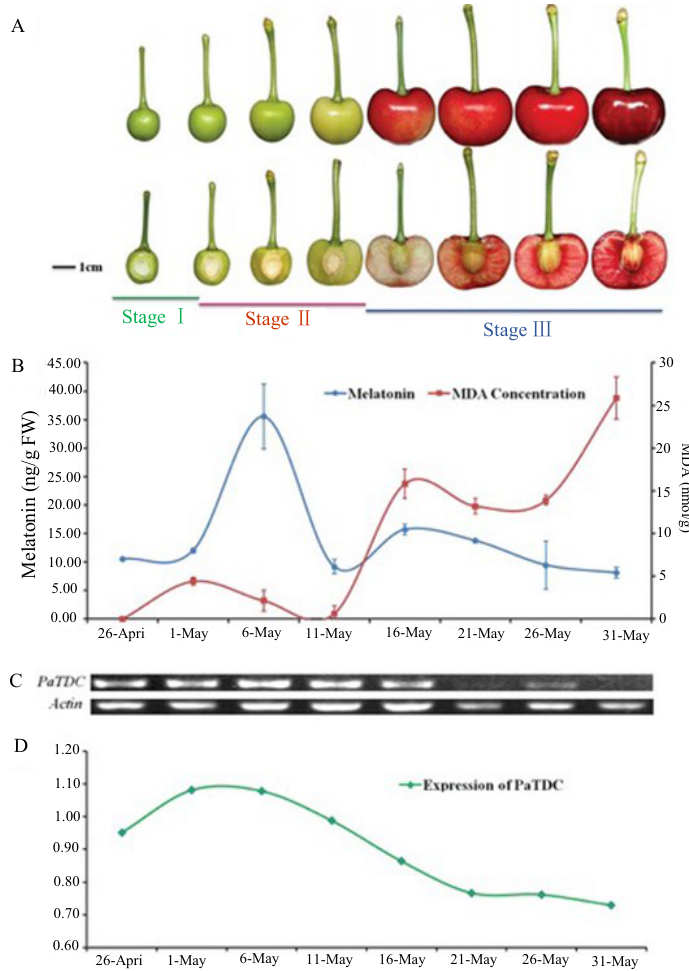
Figure 2. The association of melatonin, malondialdehyde (MDA) and the expression of PaTAC, the gene that encodes tryptophan decarboxylase, the potential rate limiting enzyme in serotonin synthesis in plants. ( A ) Intact and hemisectioned “Hongdeng” cherry fruits in different stages of development; ( B ) The levels of melatonin and the lipid peroxidation product, MDA, during fruit development; ( C ) PaTAC expression in cherry fruits during development; ( D ) Expression of PaTDC. From Zhao et al. [101] with